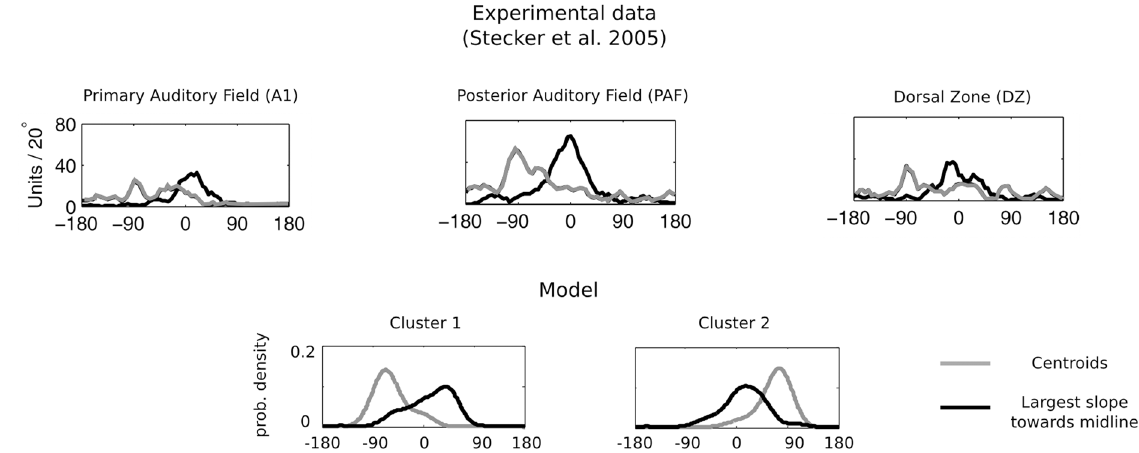
Fig 8. Distribution of tuning curve centroids and maximal slope positions in the model and experimental data. A) Histograms of positions of tuning curve centroids (gray) and maximal slopes towards the midline (black) measured experimentally in the auditory cortical areas from the cat. Figure modified from [8]. B) Distribution of the same features computed for model tuning curves belonging to each